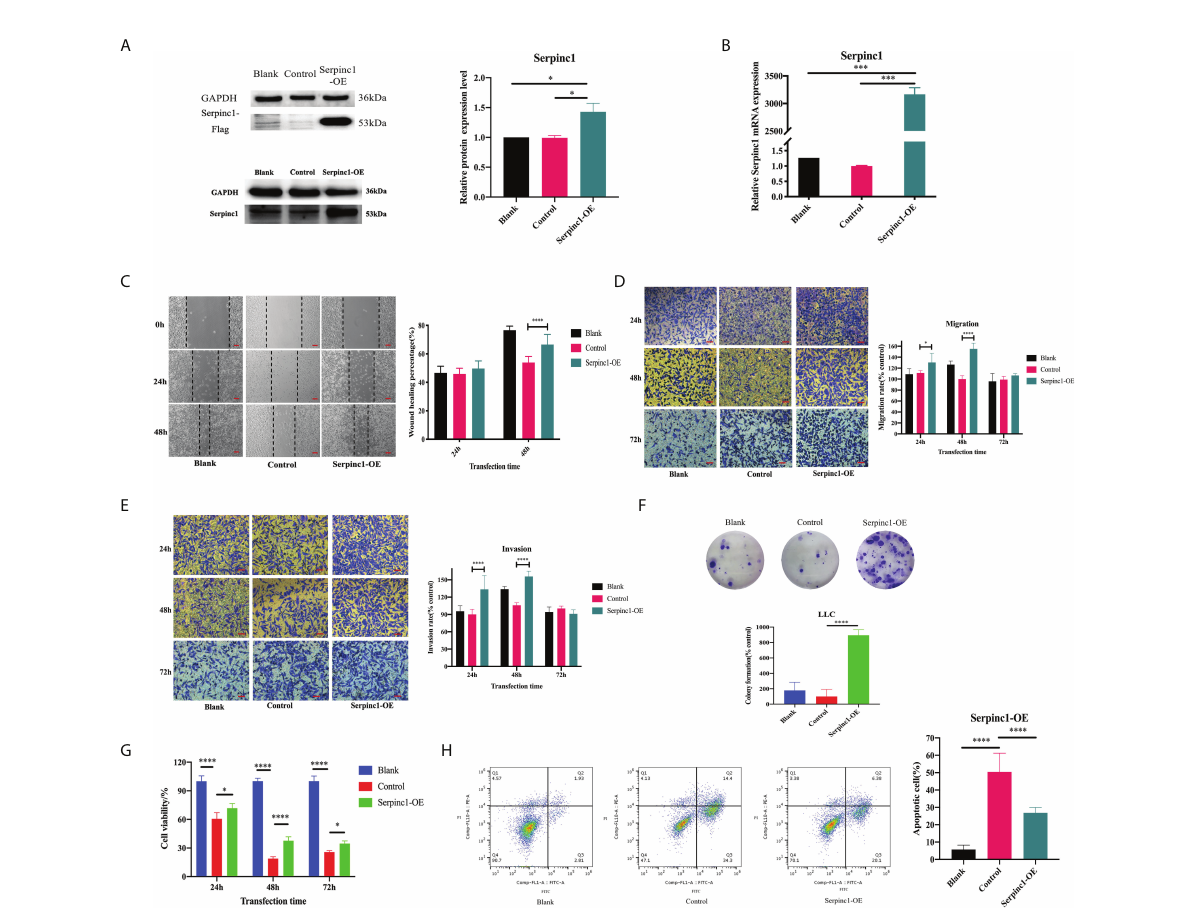
FIGURE 8 Effects of Serpinc1 gene on cell migration, invasion, proliferation, and apoptosis. The transfection of Serpinc1 was determined using (A) Western blot analysis and (B) qRT-PCR by one-way ANOVA ( n = 3). (C) Wound healing assay was measured and analyzed using two-way ANOVA ( n = 3, magni fi cation ×200). The rates of (D) migration and (E) invasion were determined with transfection for 24, 48, and 72 h with two-way ANOVA ( n = 3, magni fi cation ×400). (F) Colony formation assay ( n = 3) and (G) CCK8 assay ( n = 5) of Serpinc1 overexpressing LLC cells were used to determine cell viability with ANOVA. (H) Apoptotic cells post-transfection were detected on fl ow cytometry using one-way ANOVA ( n = 6). * p < 0.05, *** p < 0.001, **** p < 0.0001. Serpinc1 -OE, Serpinc1